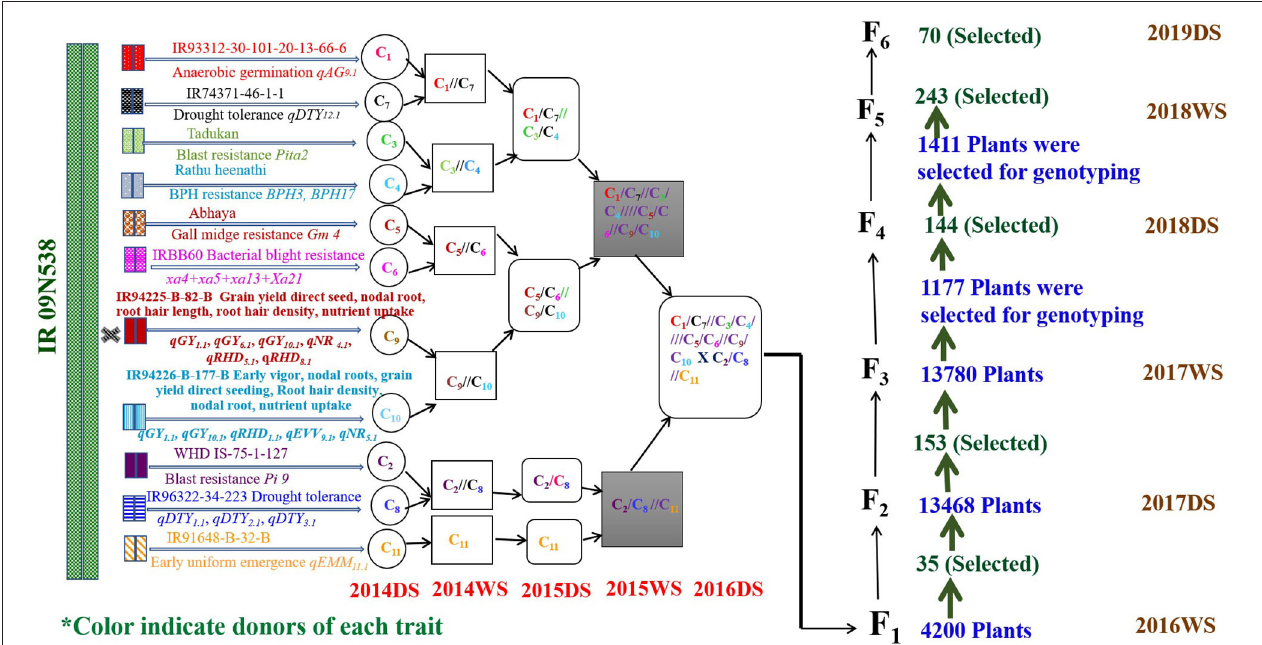
FIGURE 2 | Detailed schematic representation of crossing strategy followed for the introgression of QTL/genes from 12 donors in the background of IR09N538 and the number of plants selected across successive generations. #C: represents the cross.